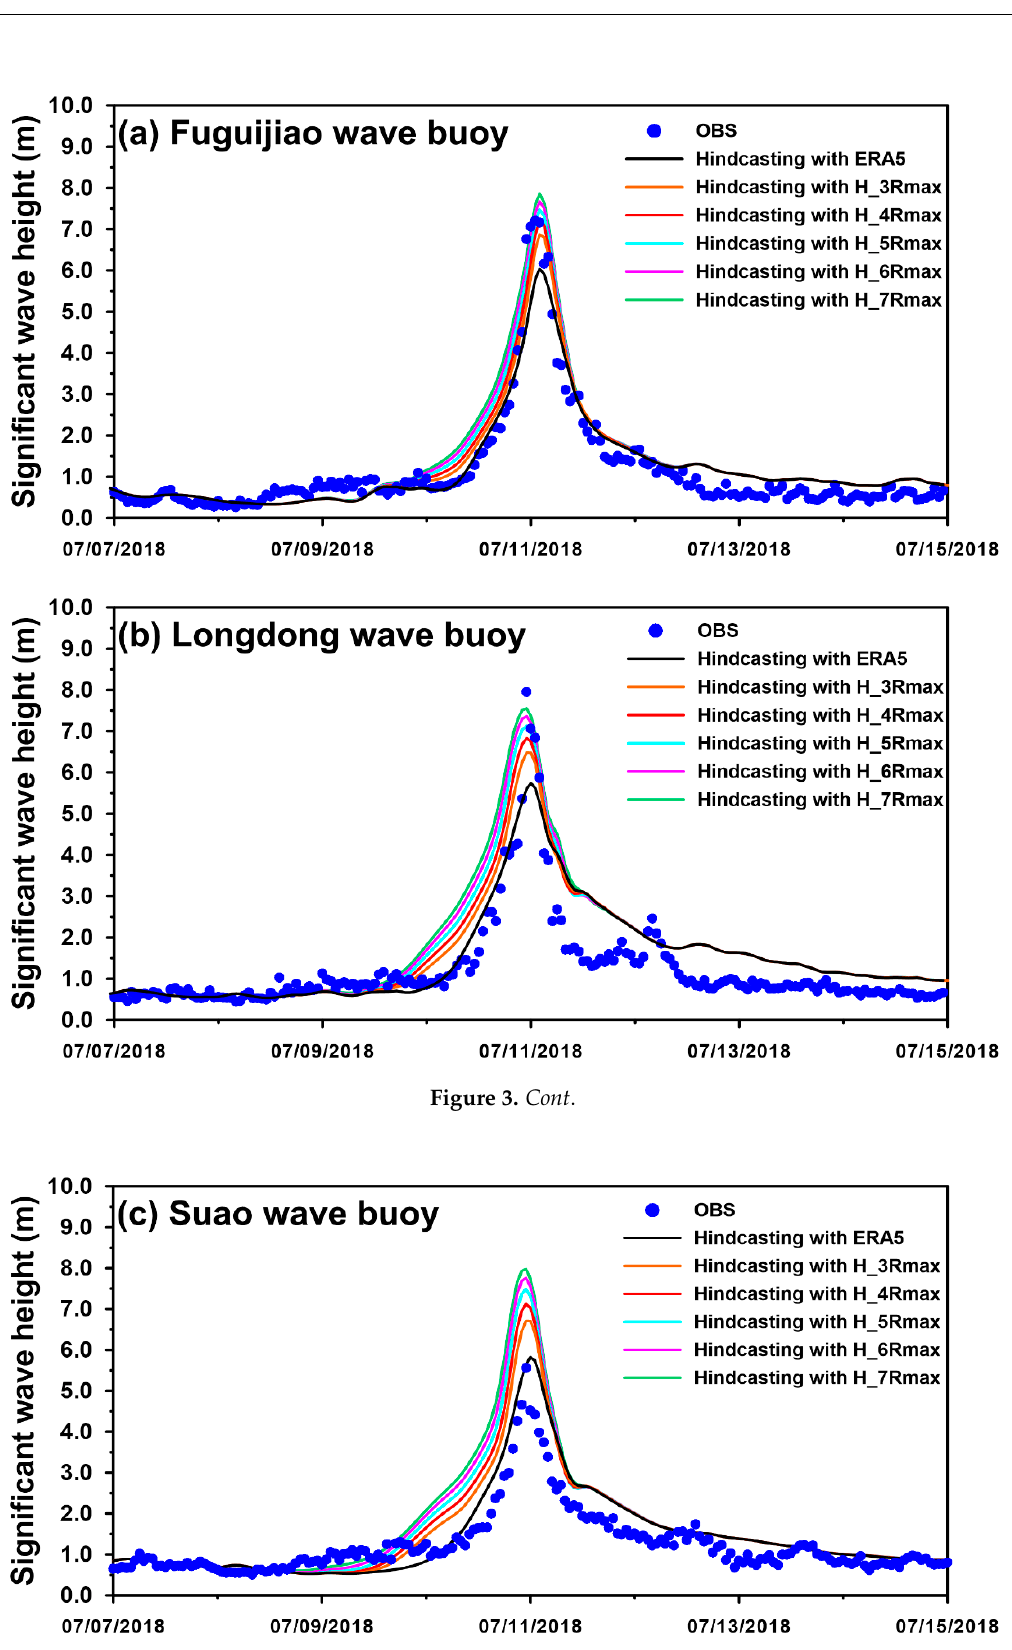
Figure 3. Comparison of the time series of the SWH between the wave simulation that used the winds from the original ERA5, from the hybrid winds with various R trs and the corresponding observations for the ( a ) Fuguijiao, ( b ) Longdong and ( c ) Suao wave buoys during the passage of Super Typhoon Maria in 2018.